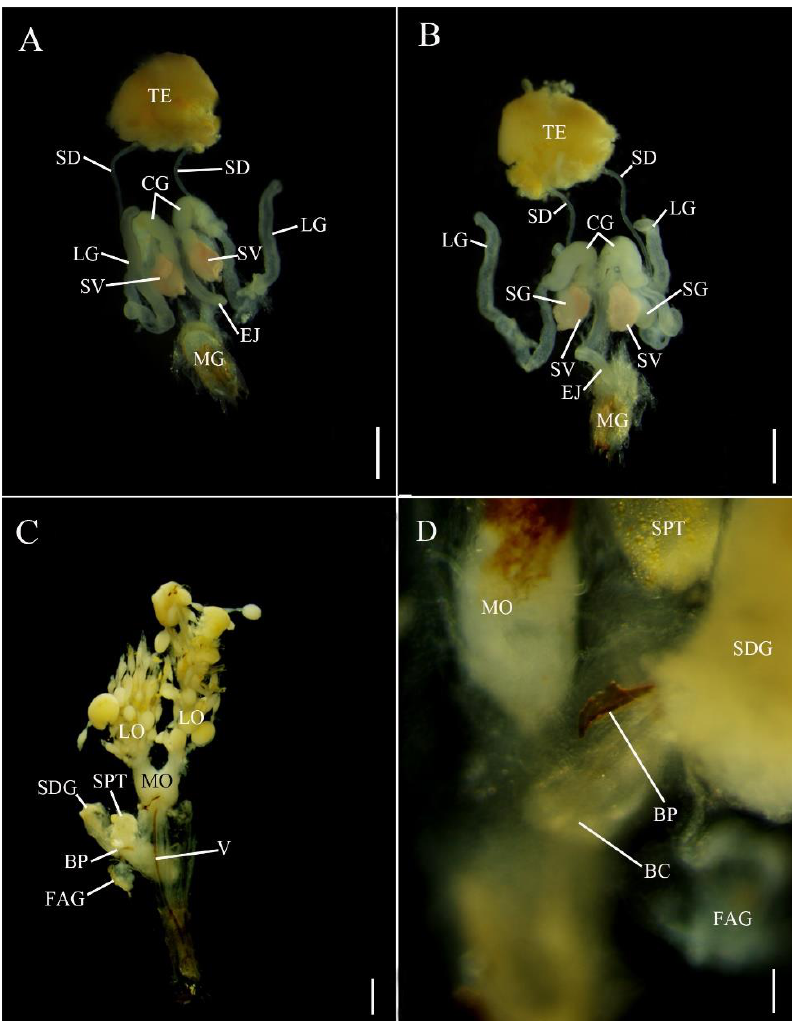
Figure 3. Reproductive system anatomy in Abscondita chinensis (( A , B ) male; ( C , D ) female). ( A , C ) Dorsal. ( B ) Ventral. ( D ) Detail in area of junction of median oviduct and bursa. Figure legends: BC, bursa copulatrix; CG, curled glands; EJ, ejaculatory duct; FAG, female accessory gland; LG, long accessory glands; LO, lateral oviducts; MG, male genitalia; MO, median oviduct; MOP, median oviduct plate; OV, ovaries; SD, seminal ducts; SDG, spermatophore-digesting gland; SG, short accessory glands; SPT, spermatheca; SV, seminal vesicle; TE, testes; V, valvifer. Scale bars for ( A – C ): 0.5 mm, ( D ): 0.1 mm.